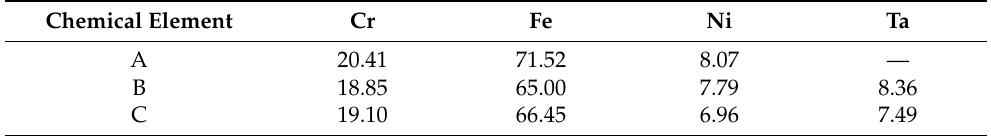
Table 6. EDS results of steel side welds